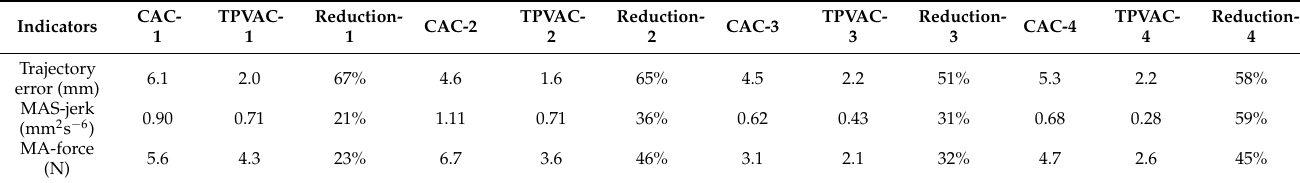
Figure 7. Robot end tool trajectory versus task path and trajectory error. Table 2. The average values and reduction rates of each group of